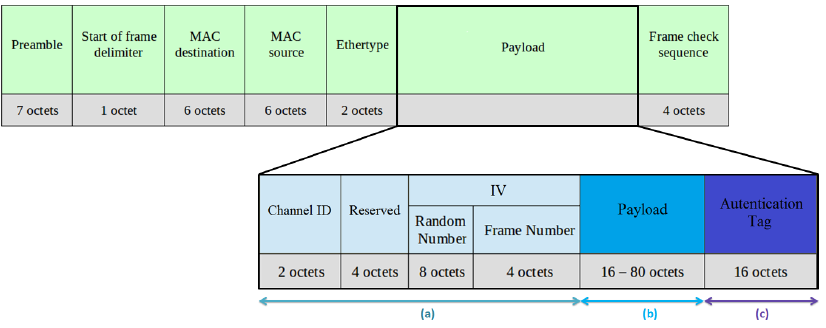
Figure 3. Configuration Over Ethernet secure (COEsec) frame format. ( a ) Data required for encryption/decryption tasks (Channel ID and IV). ( b ) Encrypted configuration data. ( c ) Tag that provides authentication and integrity to the